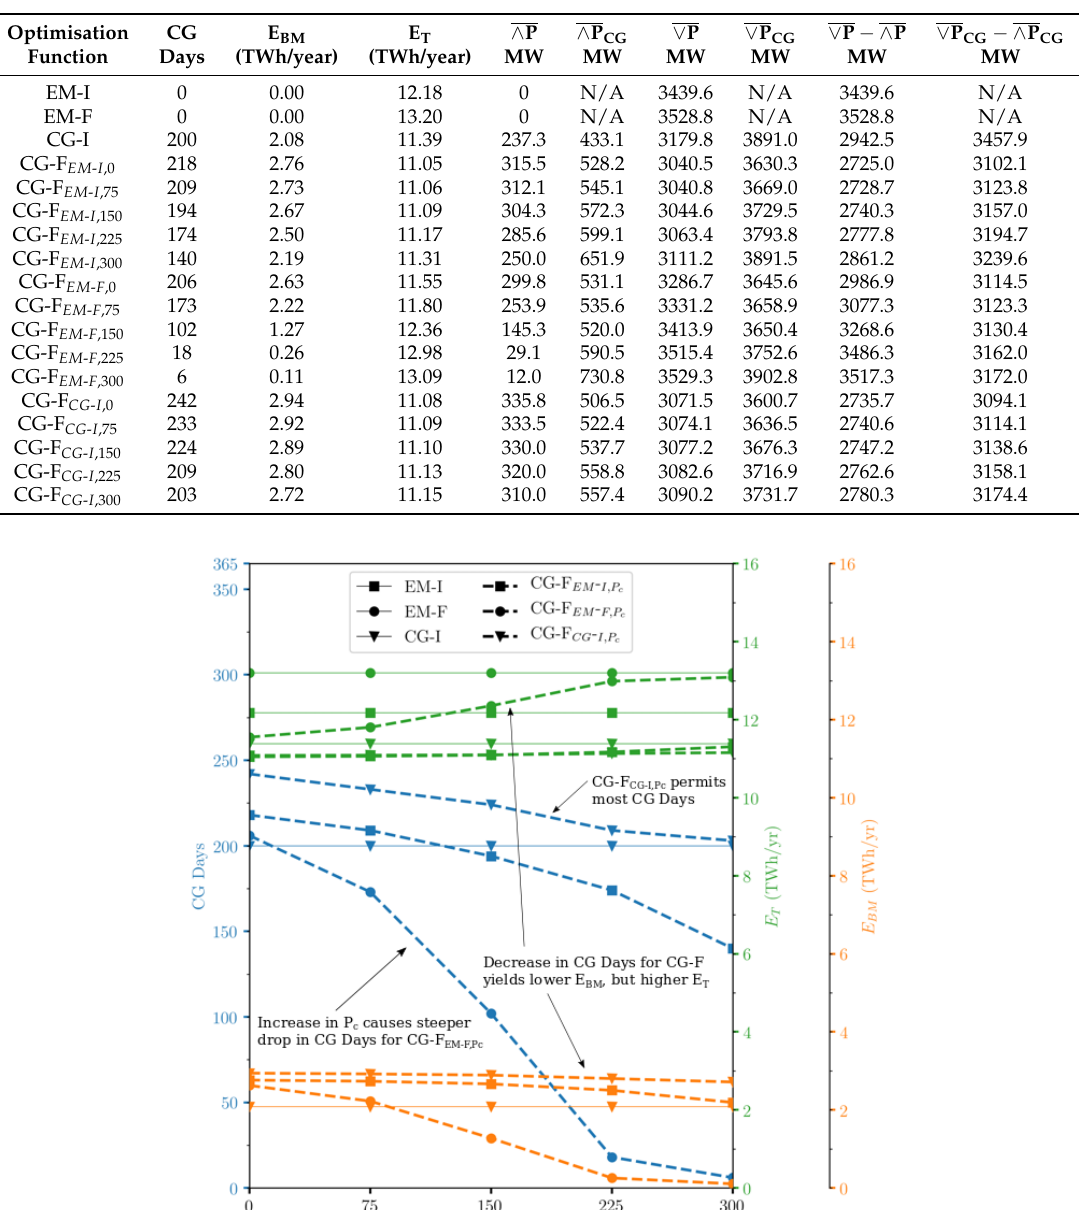
Table 3. Energy and power output results of all optimisation cases over 705 tidal cycles ( ≈ 1 year). CG-F subscript indicates associated δ and cut-off power P c (MW). Days where continuous generation is achieved are indicated as CG Days, as well as the associated proportion of the total energy E T (TWh/year) to be traded in the idealised baseload market E BM (TWh/year). ∧ P and ∧ P CG (MW) indicate average daily minimum cumulative power output over the year and exclusively on CG Days, respectively, while ∨ P and ∨ P CG (MW) show equivalent daily average power peaks. The combined installed capacity of the power plant system is 6195.2 MW.